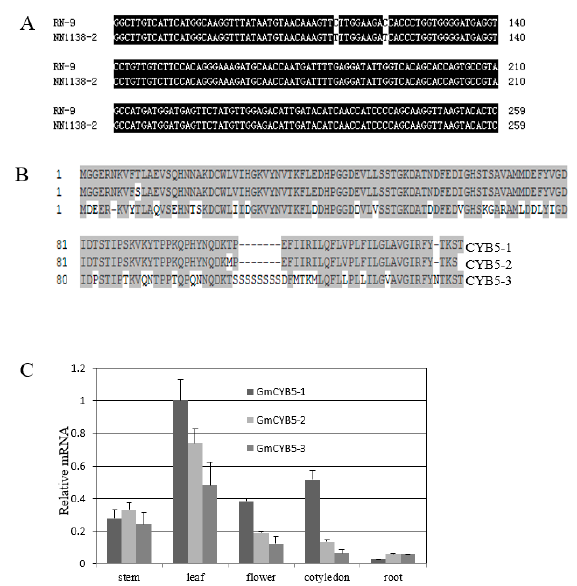
Figure 2. Sequence analysis of GmCYB5. ( A ) The full cDNA sequence alignment of GmCYB5-1 from resistant (RN-9) and susceptible (NN1138-2) cultivars. ( B ) Amino acid sequence alignment of GmCYB5 isoforms was carried out using ClustalW in the Megalign program of the DNASTAR package, with identical residues shaded in gray. Numbers indicate the position of amino acid residues. Results are representative of two to three independent experiments. ( C ) Relative mRNA levels of GmCYB5 isoforms in different tissues of soybean plants (cv. NN1138-2) as determined by quantitative RT-PCR analysis. Error bars indicate SD ( n = 3).